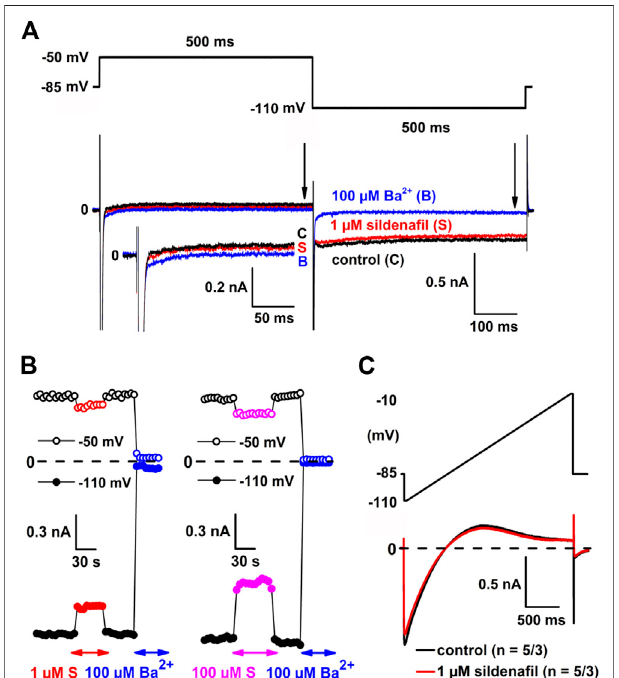
FIGURE 1 | Sildena fi l inhibits inward recti fi er potassium current ( I K1 ). (A) The experimental protocol (upper panel) and representative current traces in control conditions (C), under the effect of 1 µM sildena fi l (S) and 100 µM Ba 2+ (B) at − 50 mV and − 110 mV (lower panel); inset: current traces at − 50 mV in detail; arrows indicate the approximate time of analysis of I magnitude. (B) Changes of I K1 at − 50 mV and − 110 mV during subsequent applications of 1 µM sildena fi l and 100 µM Ba 2+ (left panel) and the highest sildena fi l concentration 100 µM (right panel). (C) Average current-voltage relationship in control and under the effect of 1 µM sildena fi l ( n = 5/3).